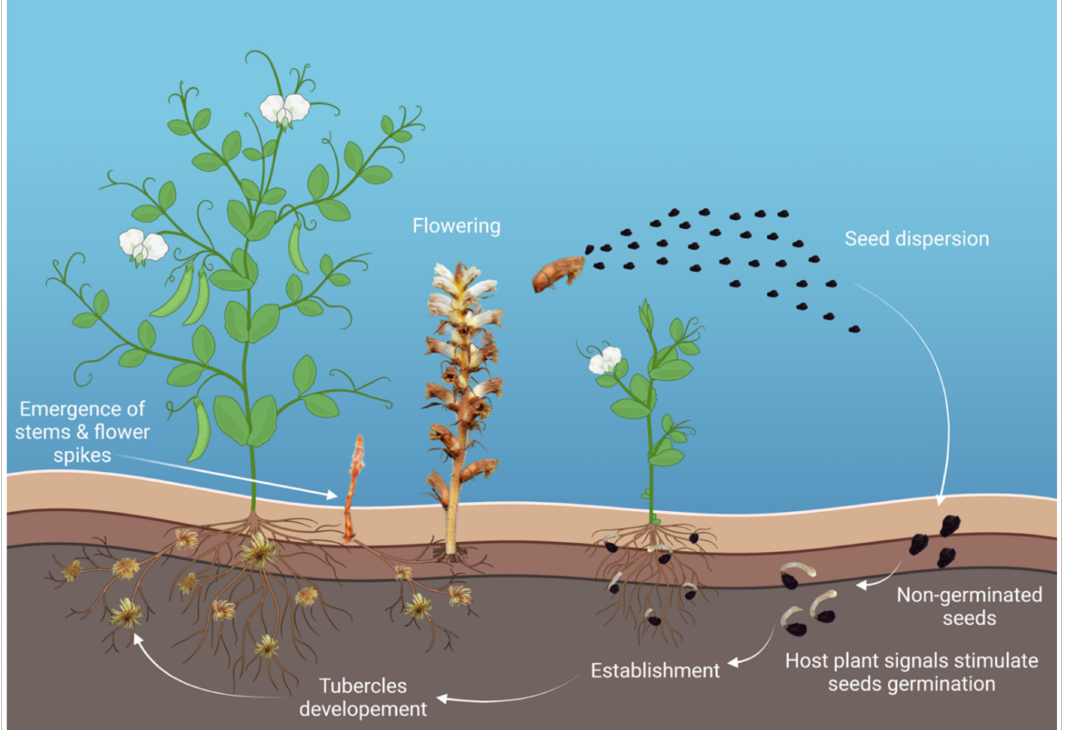
Figure 4. Broomrape infection life cycle, exhibiting below- and above-ground scenarios. (Illustration made in